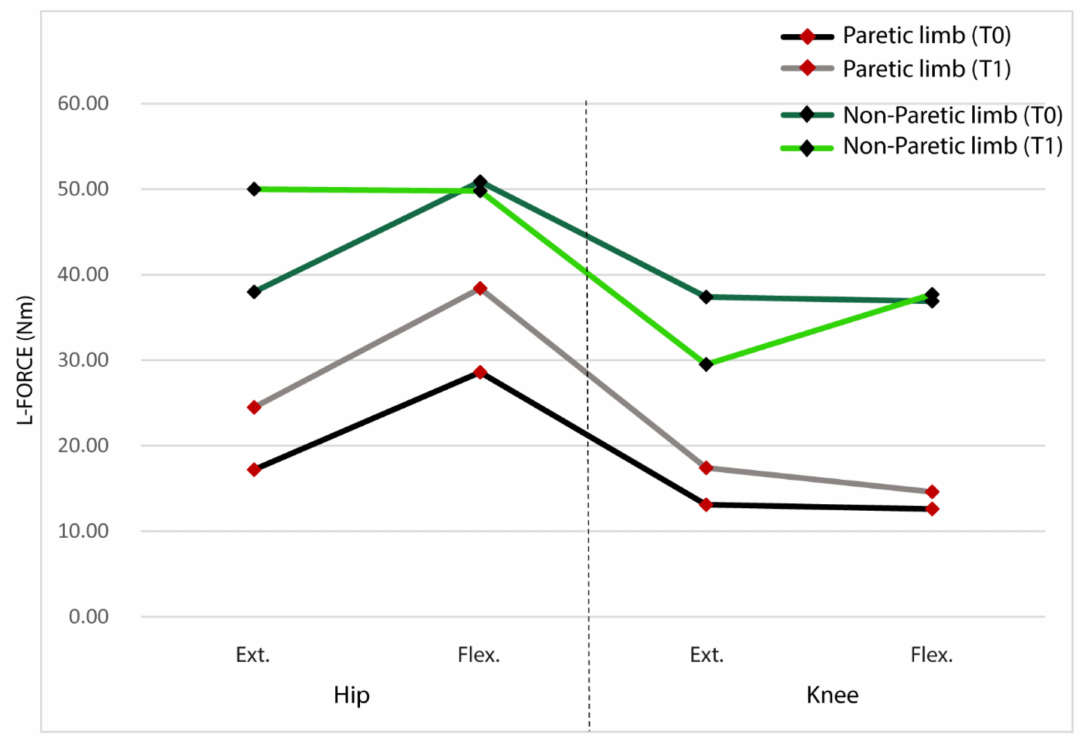
Figure 2. L-FORCE (lower limb-force) measures (mean) of paretic and non-paretic limb at basal assessments T0 and one-month follow-up